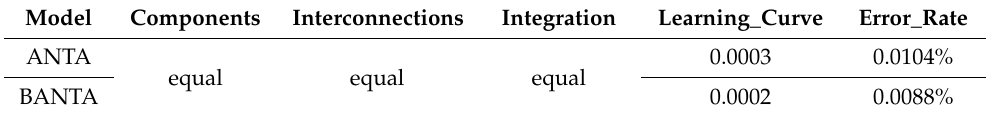
Table 4. Complexity metrics of the ANTA and BANTA methods.